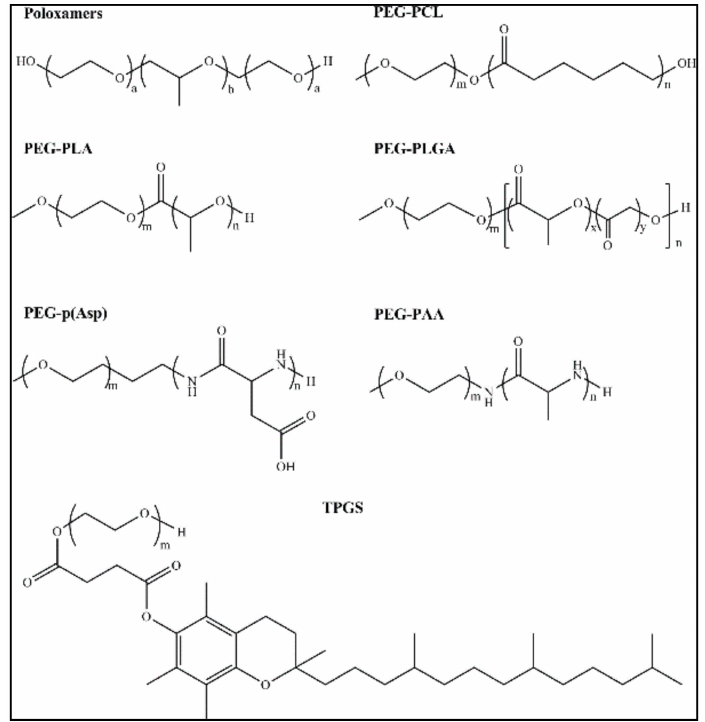
Figure 3. Structures of some commonly used polymers as micellar carrier: poly(ethylene glycol)- poly( ε -caprolactone) copolymers (PEG-PCL); poly(ethylene glycol)-b-poly( L -lactide) (PEG-PLA); Poly(ethylene glycol) methyl ether-block-poly(lactide-co-glycolide) (PEG-PLGA); Poly(ethylene glycol)-block-poly( L -aspartic acid) (PEG-p(Asp); poly(ethylene glycol) poly(amino acid) (PEG-PAA);, d- α -tocopheryl polyethylene glycol 1000 succinate (TPGS). Reprinted with permission from [52]. Copyright © 2018, American Chemical